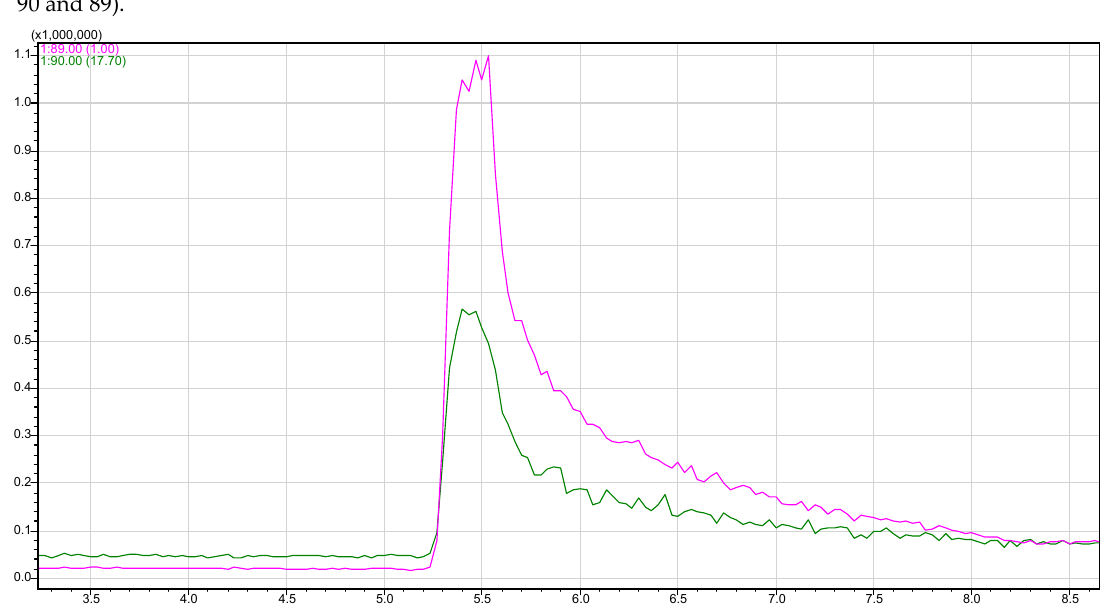
Figure 2. Magnified HILIC-PDA ( A ) and HILIC-ESI/MS SIM ( B ) chromatograms of a standard OA solution at 40 μ g/mL.